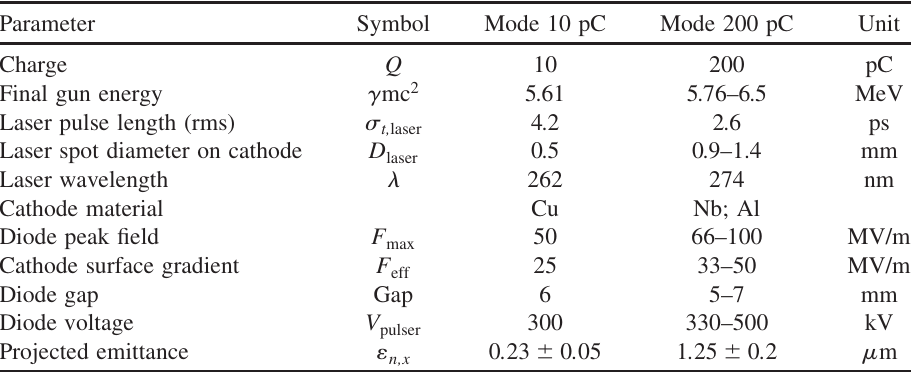
TABLE II. Summary table of the best measured emittance obtained with the diode-rf gun for the two modes of operation of SwissFEL (10 and 200 pC). Emittance at 200 pC corresponds to an average over more than ten measurements.